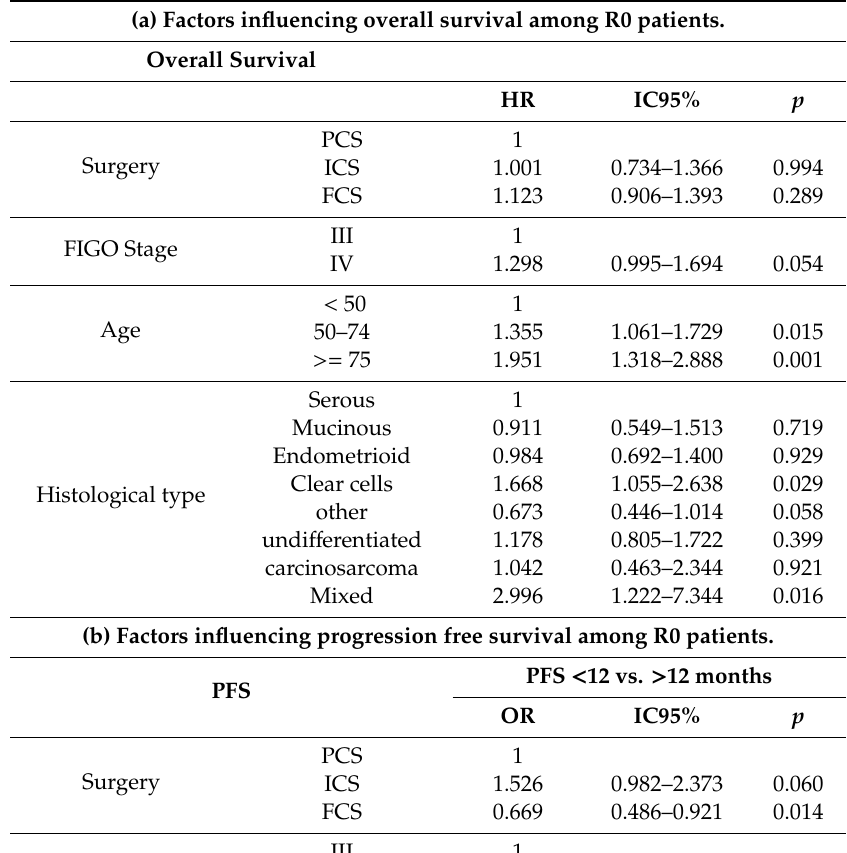
Table 4. Factors influencing Overall Survival (OS) and PFS among R0 patients. (a) Factors influencing overall survival among R0 patients. (b) Factors influencing progression free survival among R0